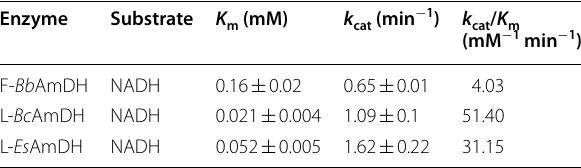
Determination of coenzyme kinetic parameters using the same substrate 2-pentanone. The values were generated by fitting the initial specific activity data to the Michaelis–Menten equation using nonlinear regression with GraphPad Prism software. Value is means standard deviations. All reactions ± involved in the kinetic constant calculations were analyzed using a 2 M NH 4 Cl/ NH 4 OH buffer at optimum pH and temperature. All experiments were repeated 3 times